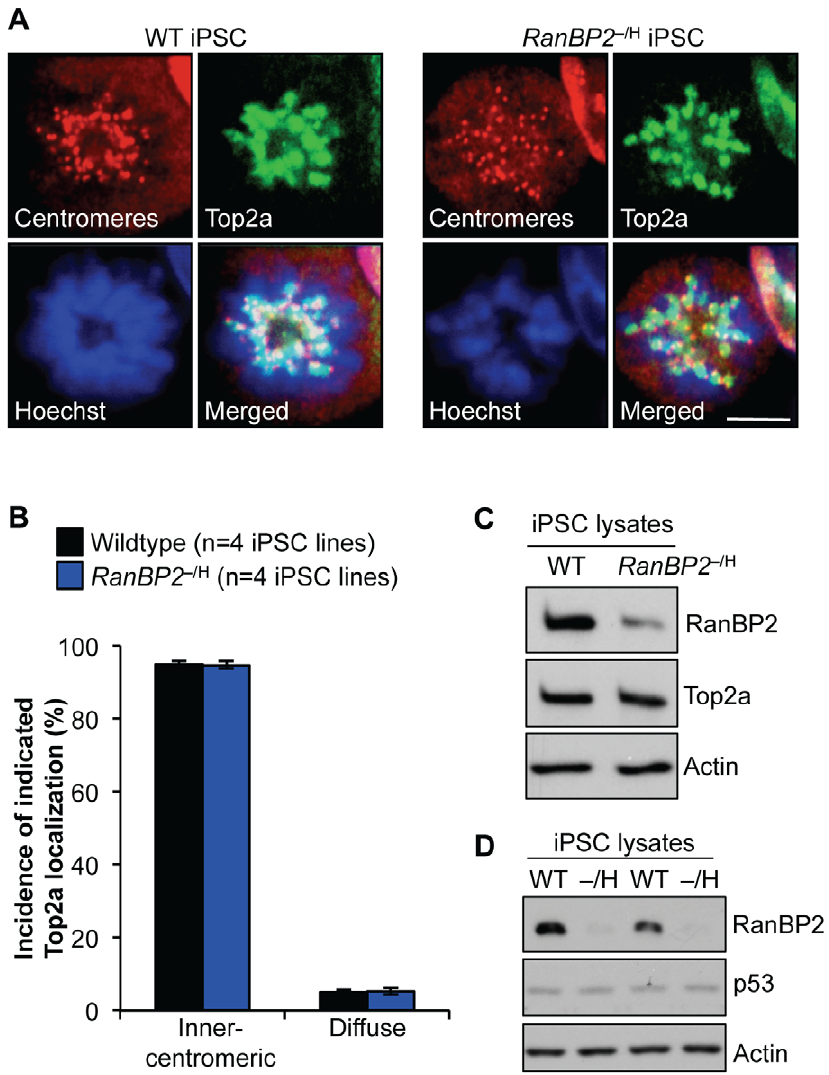
Figure 5. RanBP2 –/H iPSCs efficiently recruit Top2a to the inner centromeres. (A) Immunolocalization of Top2a in prometaphase of wildtype and RanBP2 –/H iPSCs. Centromeres are visualized with ACA antibody. DNA was stained with Hoechst. Scale bar represents 10 m m (2000 6 magnification) (B) Quantification of prometaphases with inner centromeric versus diffuse localization of Top2a. At least 50 prometaphases were analyzed per genotype. Error bars represent SD. (C) Western blot analysis of iPSC extracts probed for RanBP2 and Top2a. Actin served as a